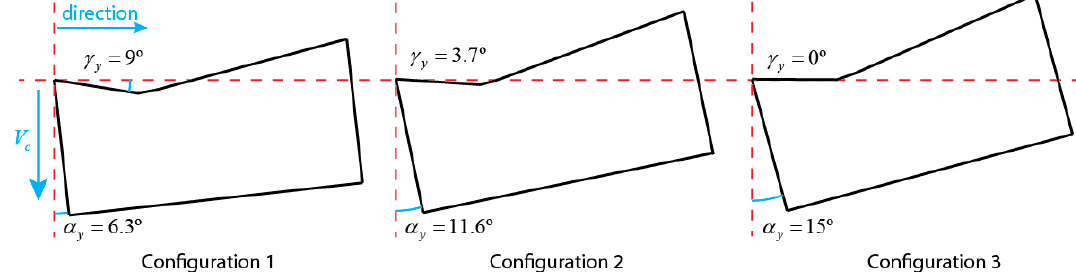
Figure 2. Schematic detail of the tool angles for each configuration. Table 3. Cutting parameters for the experimental tests.